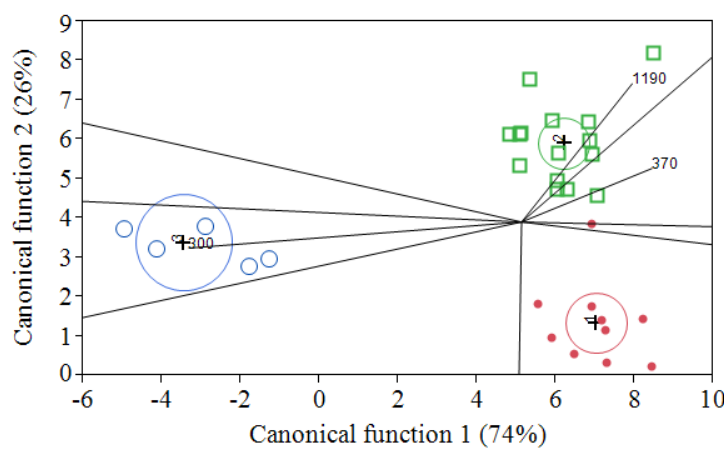
Figure 3. Linear discriminant analysis of Pinot gris (□), Chardonnay ( λ ) and Vermentino ( ○ ) grapes during alcoholic fermentation at 17 °C.